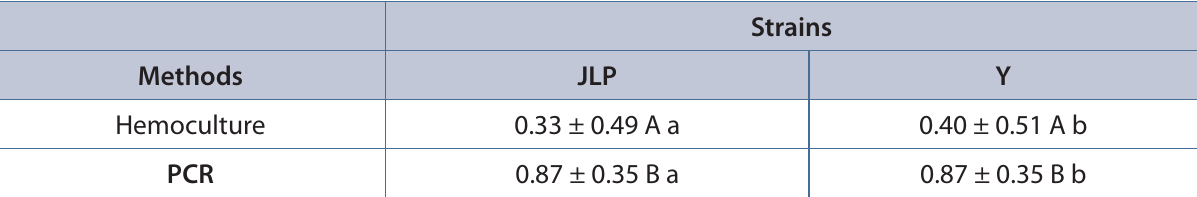
Table 4. Comparison between strains and methods (hemoculture versus PCR analysis) in lung samples from BALB/c mice infected with T.